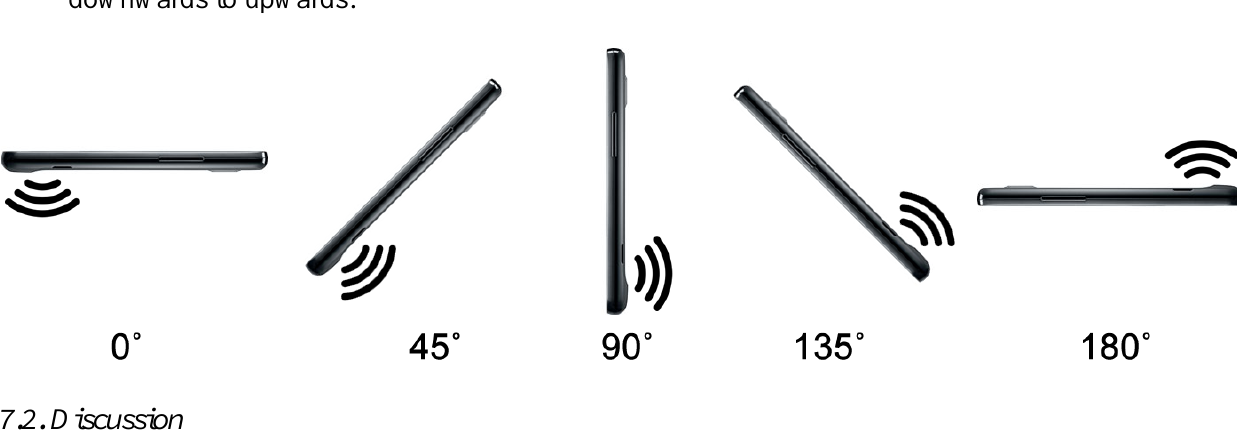
Figure 4. Five different tilt orientations in which phone was tested. The curved sound bars show direction and orientation of the phone’s main speaker as it gets rotated from downwards to